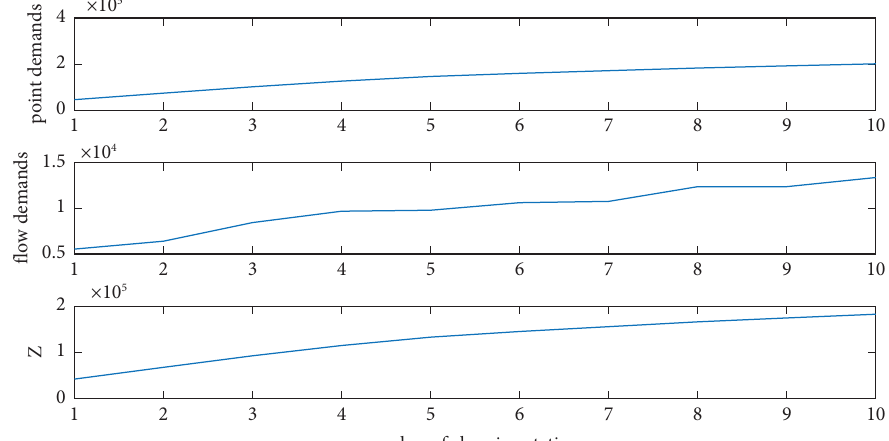
Figure 9: Covered point demands and covered path demands and the objective values with the number of charging stations increasing under θ � 0.9.